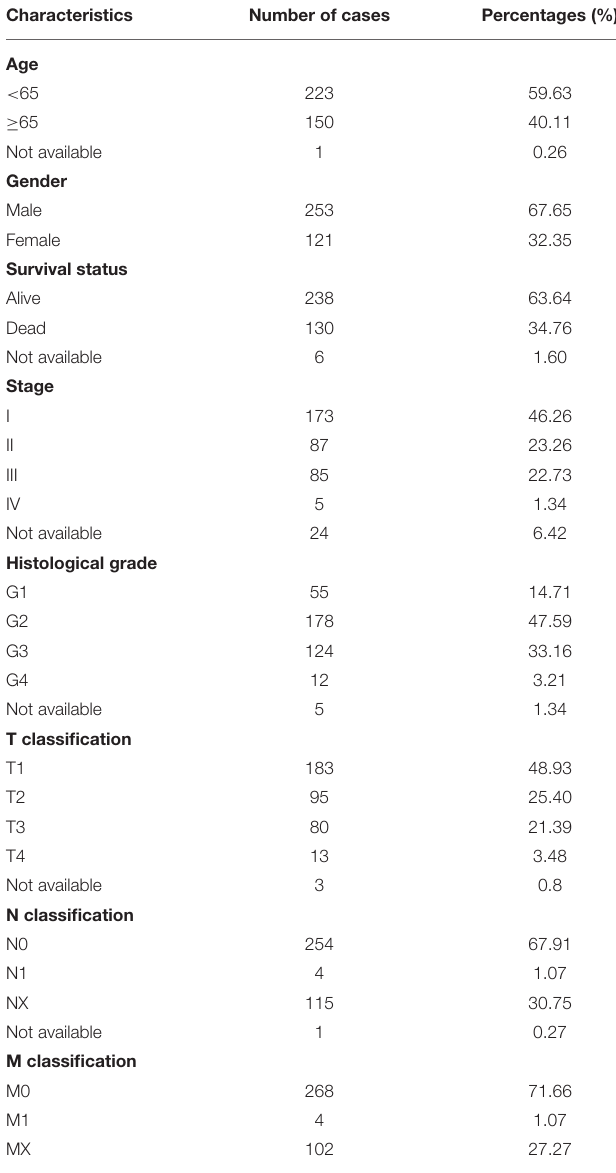
TABLE 1 | The clinical characteristic information of the HCC patients in TCGA.